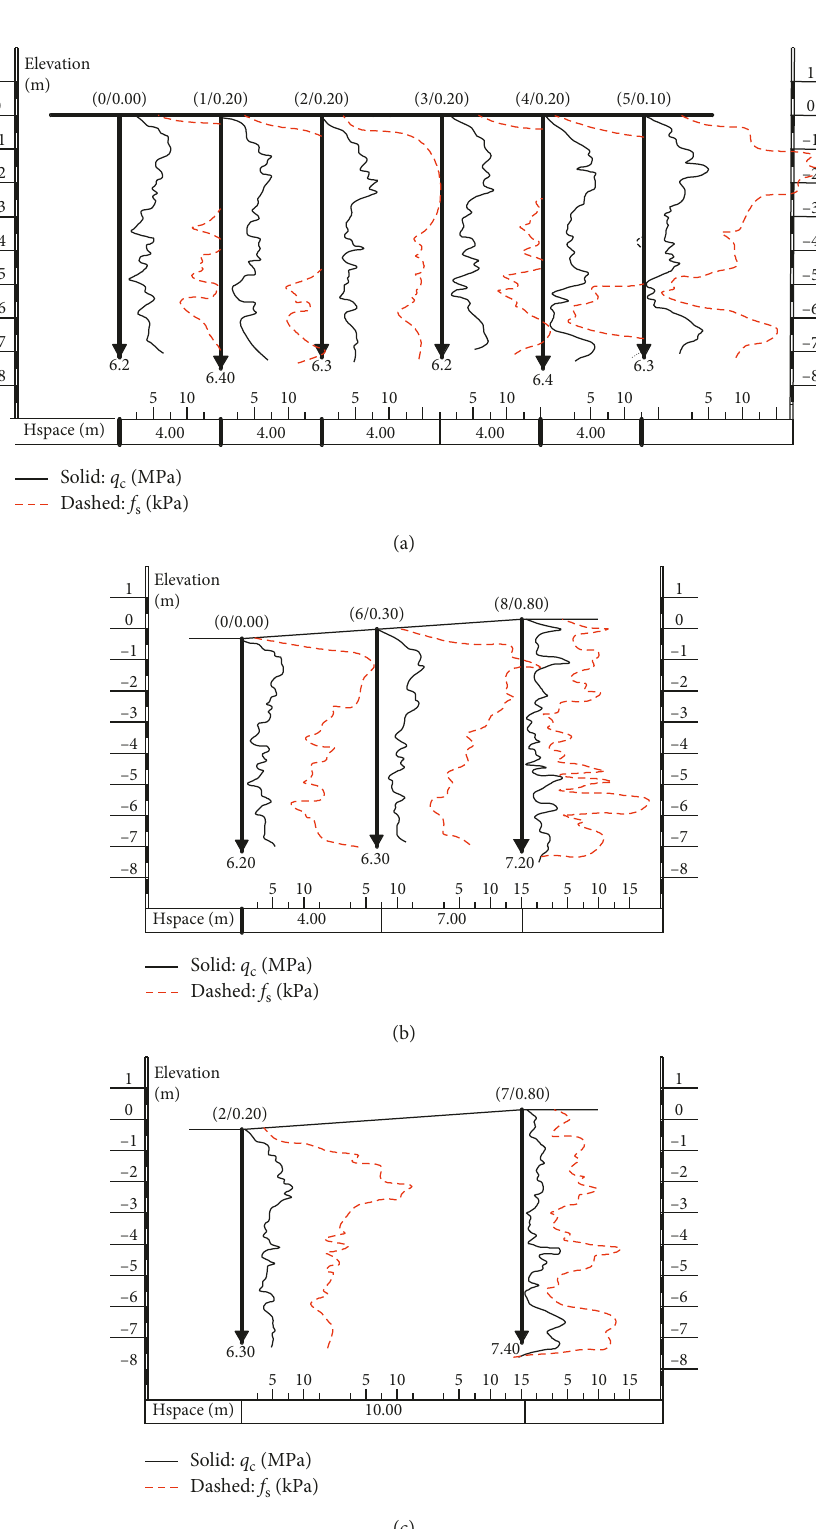
Figure 14: Results of CPT on fly ash after dynamic